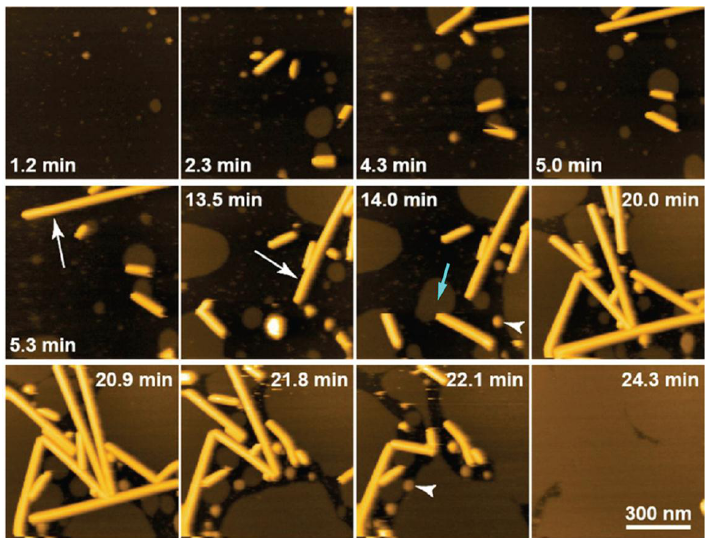
Figure 2. HS-AFM imaging of the growth of lipid nanotubes of about 20 nm height occurring in the process of SLB formation on mica. The white arrows indicate rapidly growing lipid nanotubes. The light-blue arrow indicates the interaction between an SLB patch and one end of a lipid nanotube. The arrowheads indicate liposomes. Adapted with permission from [41]. Copyright 2014 American Chemical Society.